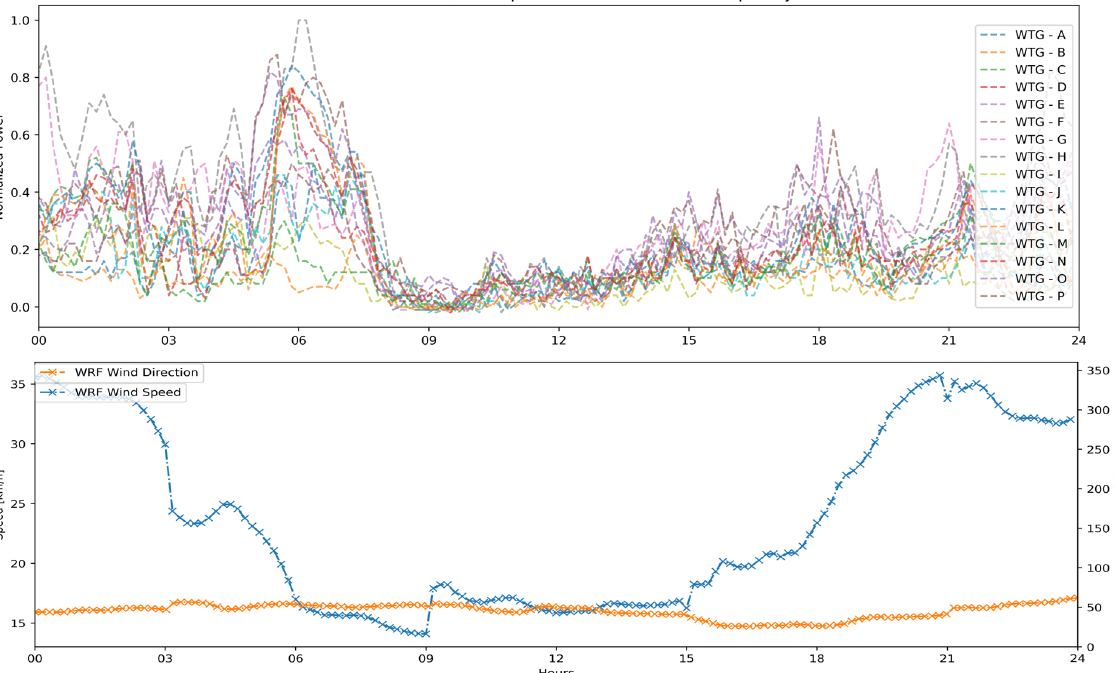
Figure 5. The generated power of each wind turbine normalized by the maximum of measured values is presented in the upper panel for a sample day. Shown in the lower panel are the WRF simulated wind speed and direction for the same day at the wind farm